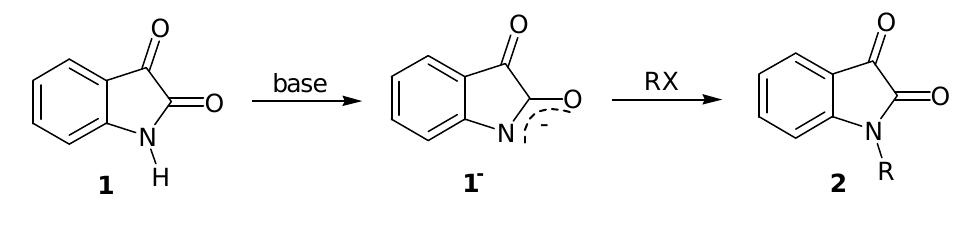
Scheme 1 . Synthetic route for N -substituted isatins 2